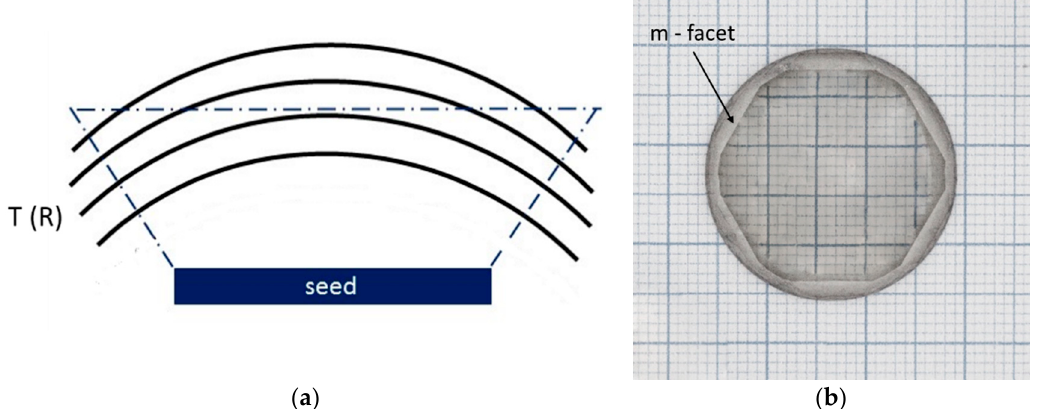
Figure 9. ( a ) Scheme of temperature distribution close to the growing crystal surface: it may allow for controlled crystal expansion and prevent crystallization on the sidewalls; ( b ) three-mm-thick HVPE-GaN grown on Ammono-GaN; equilibrium hexagonal crystal habit is well visible; c-plane is reduced; grid 1 mm.